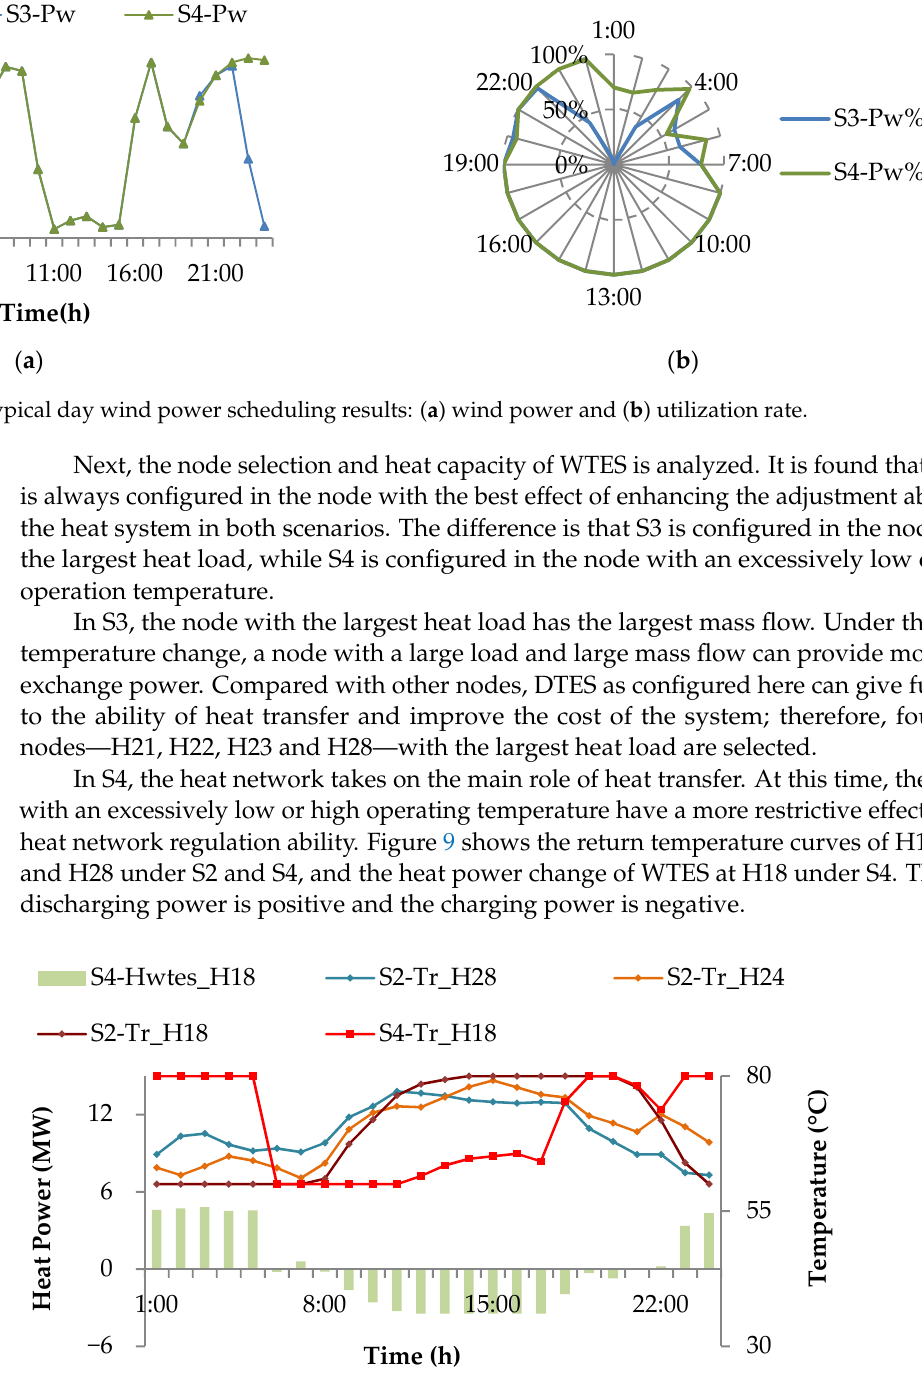
Figure 9. Return temperature and WTES power of some nodes in S2 and S4.